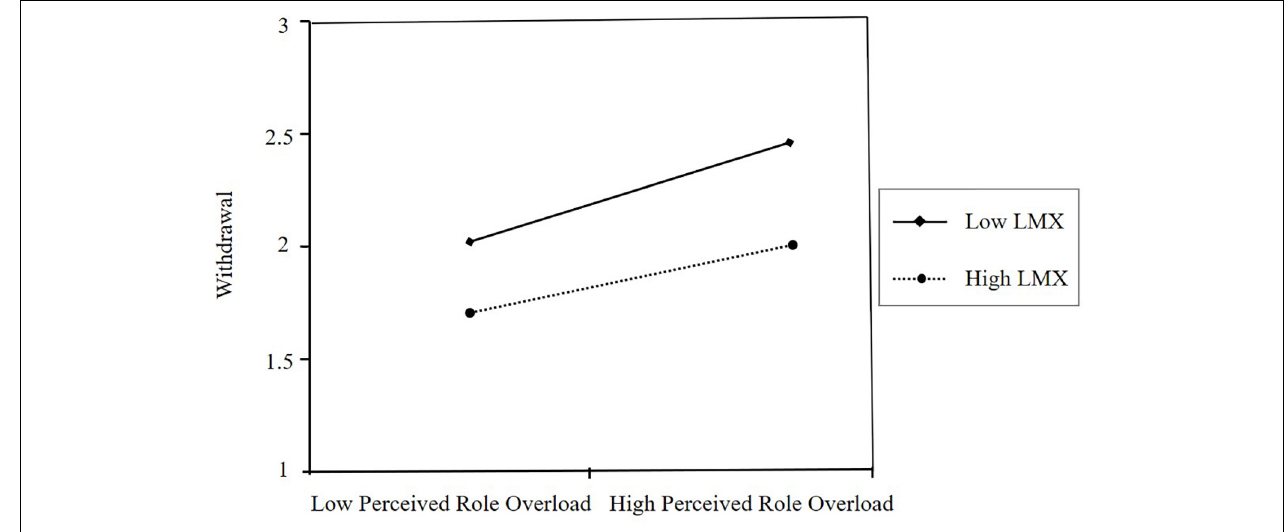
FIGURE 2 | The interactive effect of perceived role overload and LMX on withdrawal.